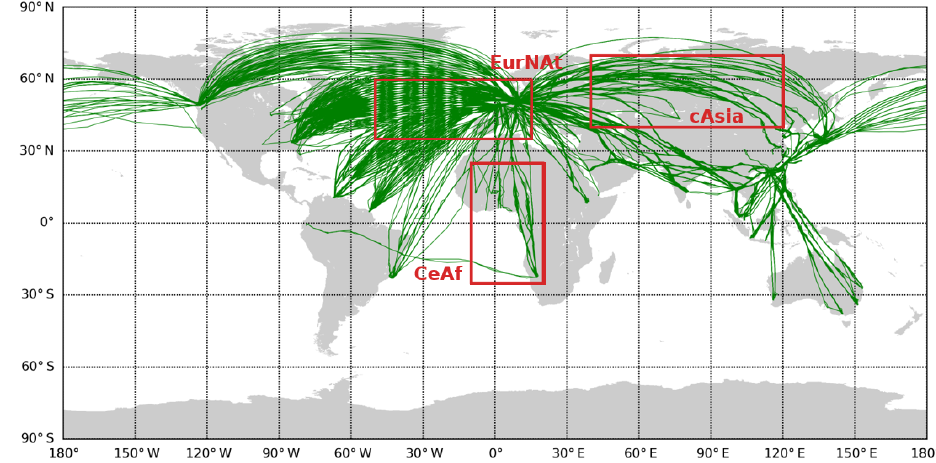
Figure 1. Trajectories of the 3022 IAGOS flights that occurred in 2013 (in green) and the delimitations of the three geographical areas used in the evaluation section (in red).